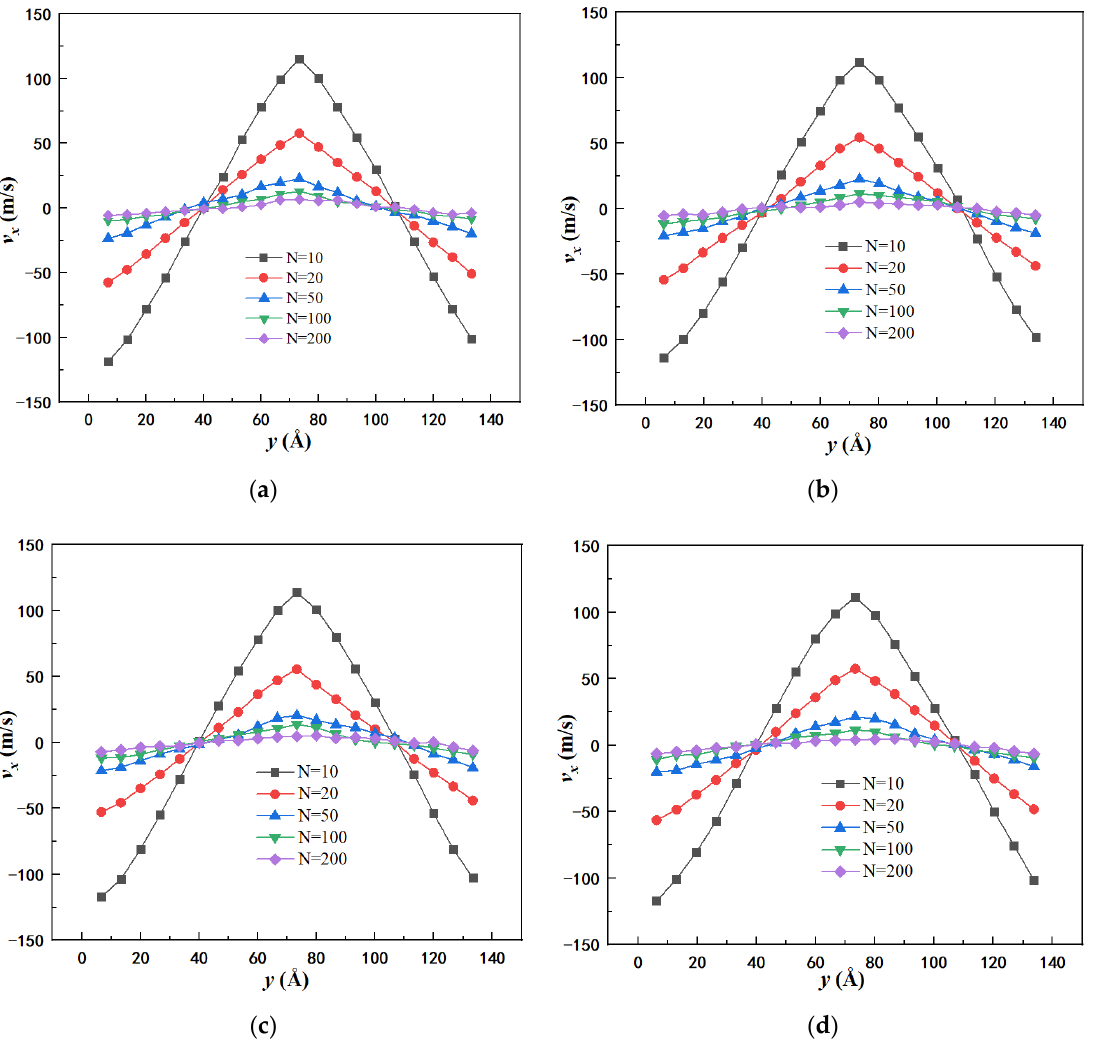
Figure 3. Velocity profiles in the x direction at momentum exchange intervals N = 10, 20, 50, 100, and 200 for: ( a ) pure kerosene; ( b ) ns36np15 solution; ( c ) ns36np5 solution; ( d ) ns60np9 solution. The shear viscosities at different shear rates for different systems are shown in Figure